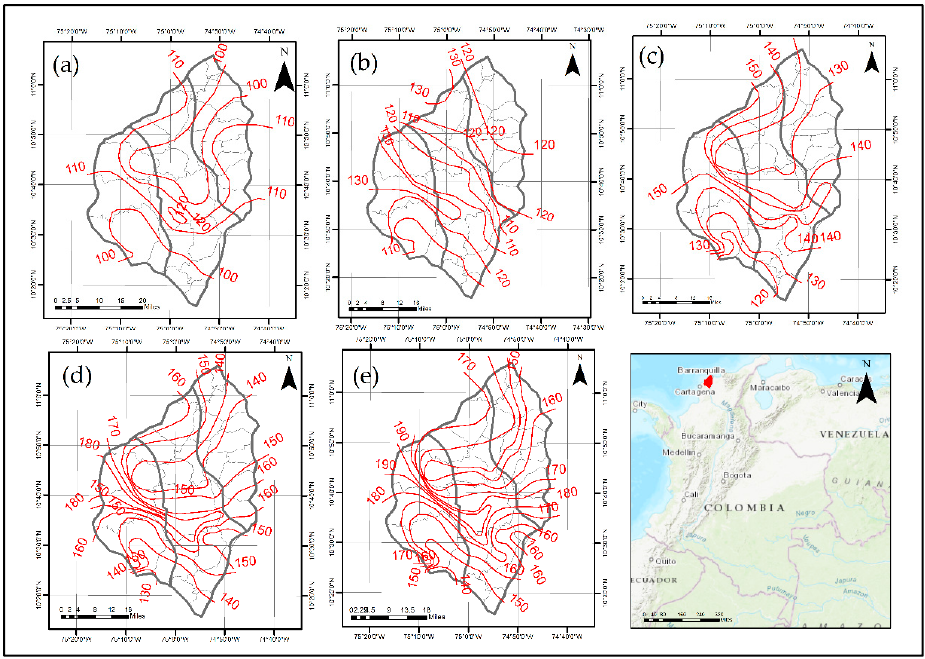
Figure 10. Mixed isohyetal maps: ( a ) five years, ( b ) 10 Years, ( c ) 25 years, ( d ) 50 years, and ( e ) 100 years.